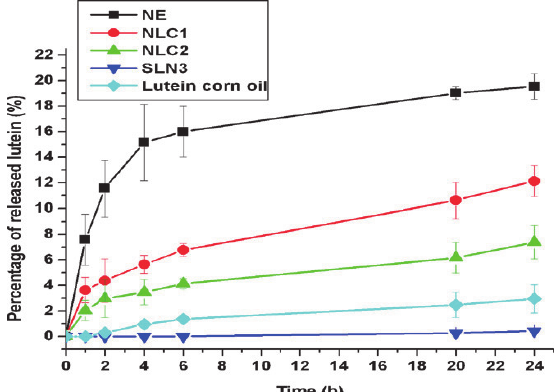
Fig. 10 Release profiles of lutein at pH 5.5 from lipid nano delivery systems. NE: nanoemulsion, NLC: nanostructured lipid carriers 1 with glyceryl tripalmitate and 2 with carnauba wax, SLN3: solid lipid nanoparticles with carnauba wax. The release profiles depend on the lipid matrix compositions, active load and mode of incorporation in the matrix and surfactant type 54) .